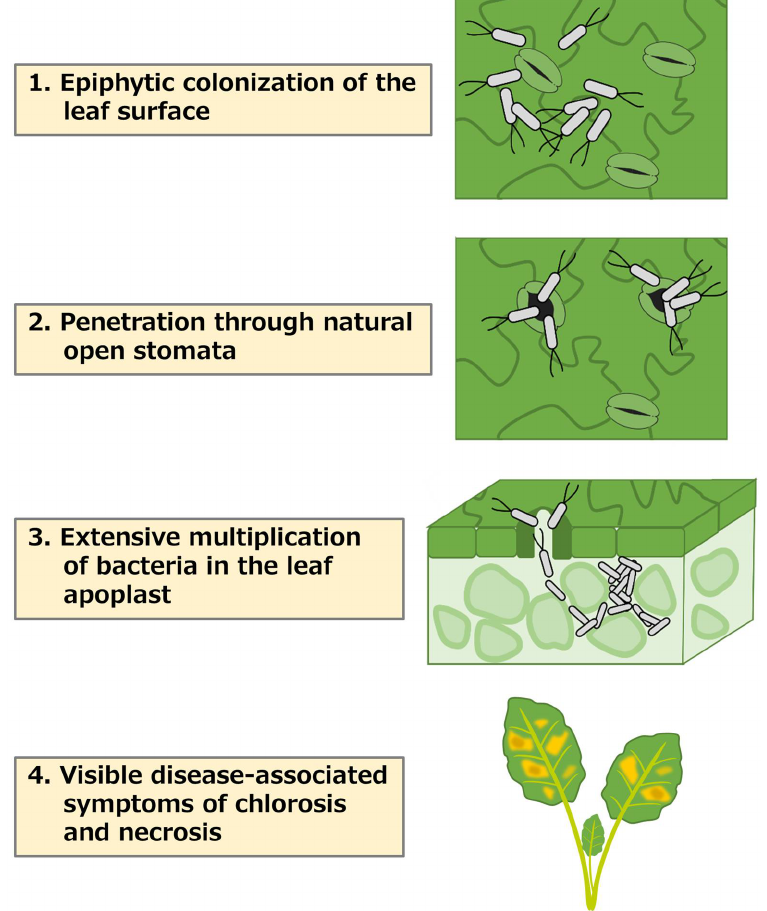
Figure 1. The infection cycle of foliar pathogenic Pseudomonas species. On healthy plant leaves, bacteria cells multiply epiphytically (1) and penetrate through open stomata (2). Cross section of a leaf showing bacteria entry, extensive endophytic multiplication, and colonization of the leaf apoplast (3). Visible disease-associated necrosis and chlorosis symptoms (4). 2. Virulence Factors Involved in the Entry of Foliar Bacterial Pathogens Foliar pathogenic Pseudomonas spp. enter the plant apoplast through natural opening sites, including stomata, hydathodes, wounds, and lenticels. One of the earliest immune responses in PTI is a stomatal-based defense to restrict bacterial entry through stomata [15]. Thus, stomata are not a passive path for pathogen invasion. For successful entry, foliar pathogenic Pseudomonas spp. need to move toward natural opening sites such as stomata and overcome plant early defense PTI. Thus, we here summarized bacterial vir- ulence factors required for stomatal entry.